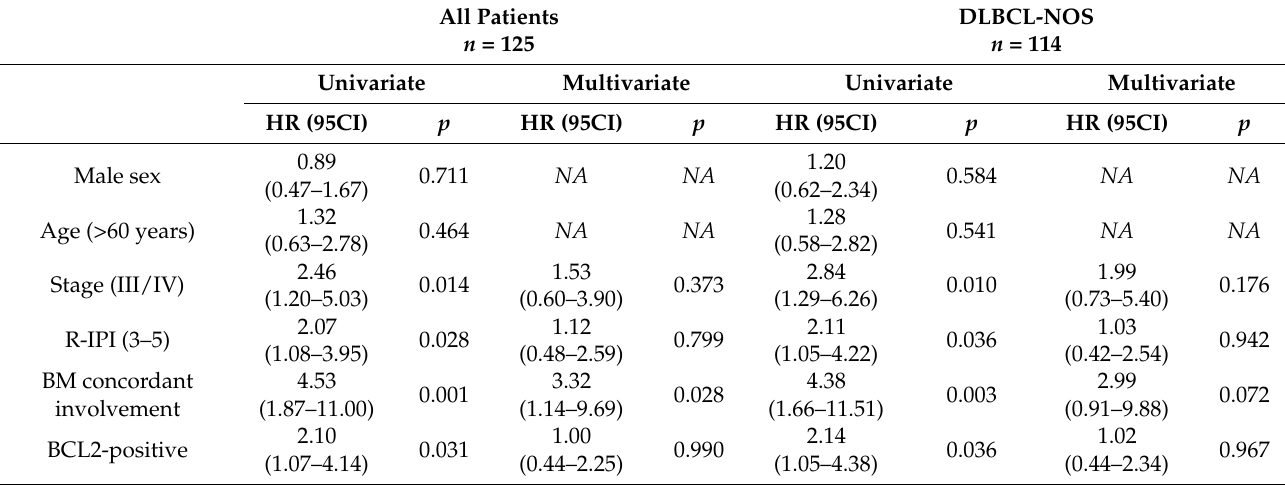
Table 2. Univariate and multivariate * analysis of primary outcome (EFS) in